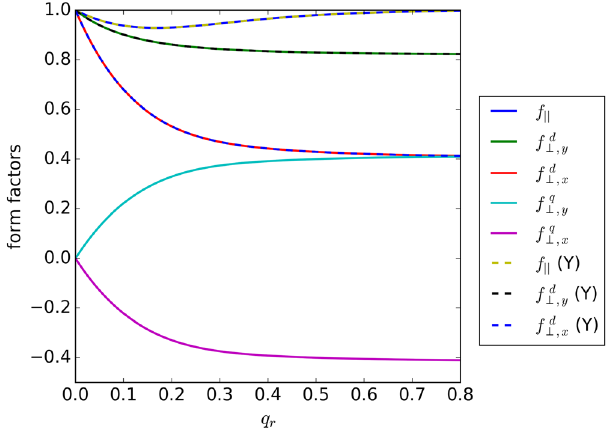
FIG. 3. Yokoya form factors as a function of q r ¼ ð a − b Þ = ð a þ b Þ . With (Y) we indicate the form factors as expressed by the integrals in Ref.